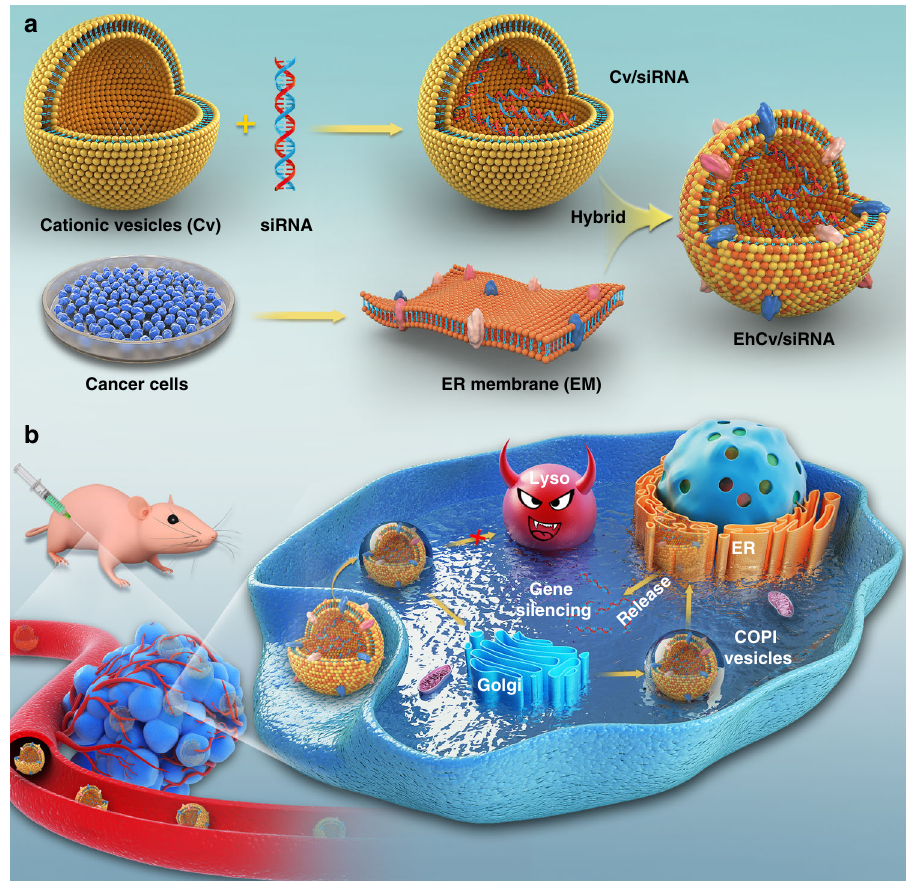
Fig. 1 The assembly process and delivery of ER membrane (EM)-hybrid small interfering RNA (siRNA)-loaded nanoplexes (EhCv/siRNA NPs). a The EhCv/ siRNA NPs were prepared with the decoration of cancer cell EM on Cv/siRNA NPs through membrane fusion; b EhCv/siRNA NPs were injected peritumorally to MCF-7 tumor in situ, then it would promote cell internalization and transport siRNA to the ER via a COPI-mediated retrograde Golgi – ER pathway instead of endosome – lysosome pathway, so as to evade intracellular lysosomal degradation and enhance siRNA silencing